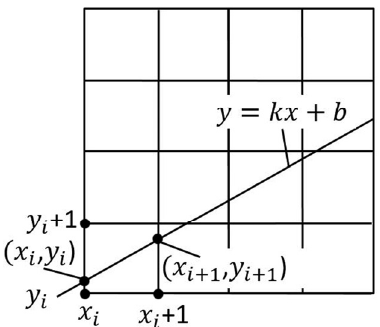
Figure 1. Schematic of Bresenham’s algorithm. Note: ( x i + 1 − x i ) > ( y i + 1 − y i ) , so x is the active direction, y is passive direction.